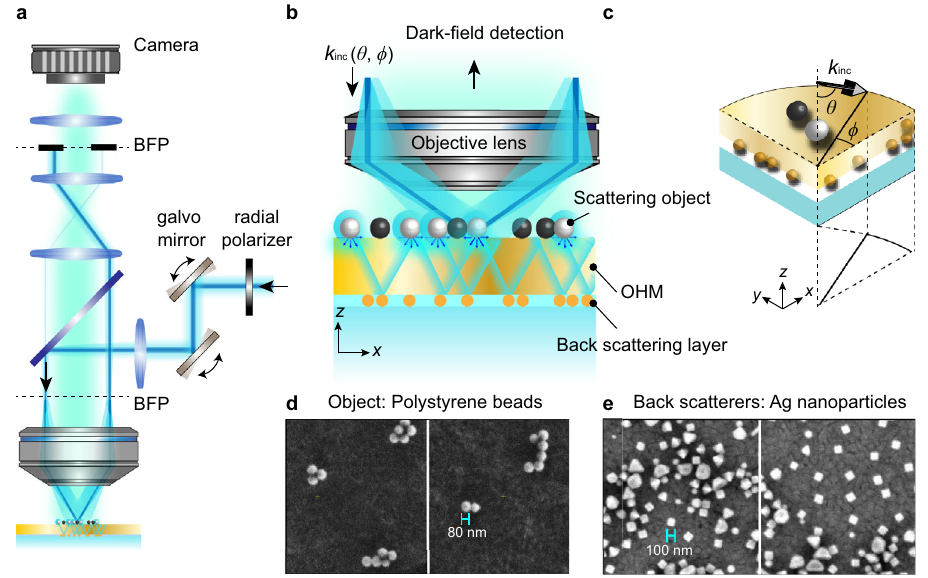
Fig. 1 | Experimental setup of the HMES nanoscopy. a – c Schematic of the HMES nanoscopy ( a ) and an enlarged view of it ( b , c ). An excitation laser beam ( λ =532nm, p -polarized) was steered via scanning galvo mirrors through a 4 f sys- tem, by which the polar angle, θ , and azimuthal angle, ϕ , of the incidence beam werede fi ned.The scattered lightfrom theobjectwaspassed through adiaphragm